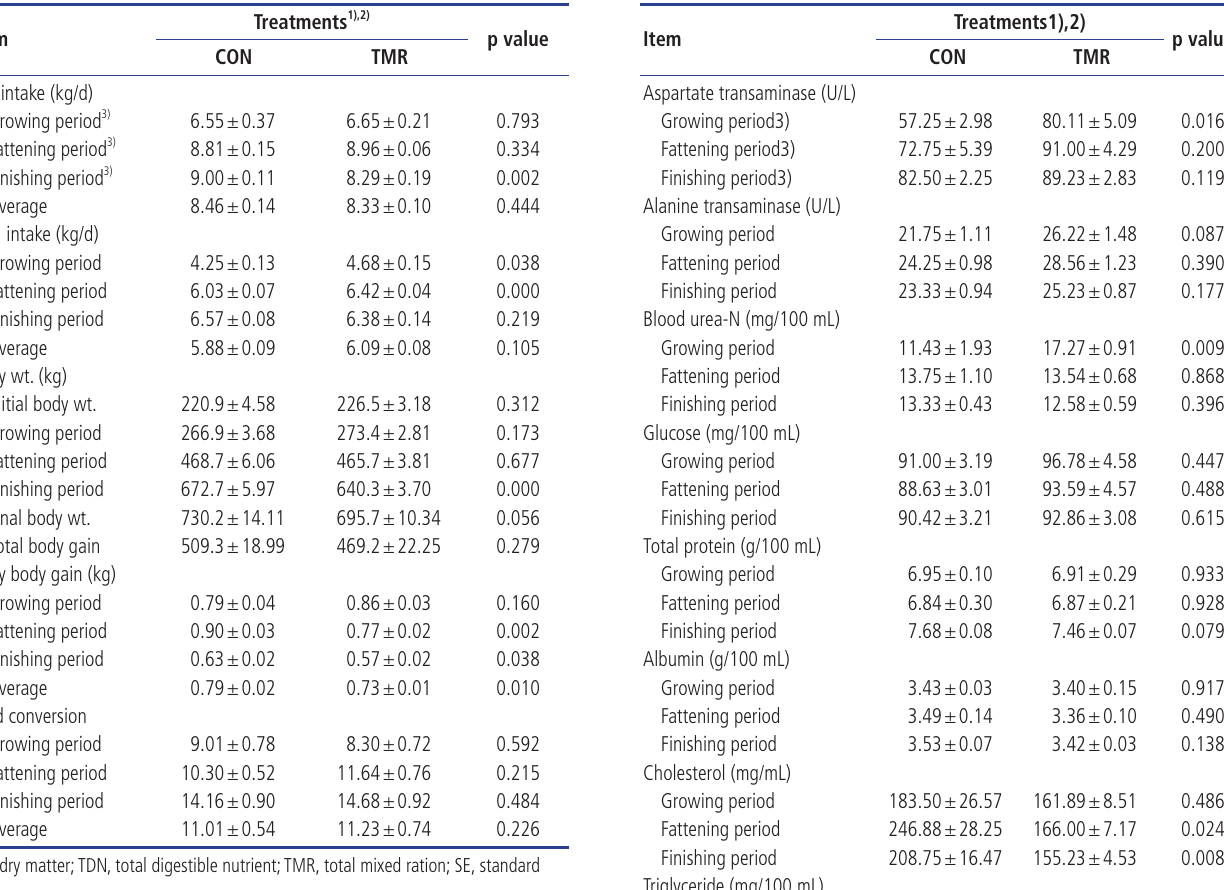
Table 3. Effect of feeding system on DM and TDN intakes, body weight gain, and feed conversion of Hanwoo steers